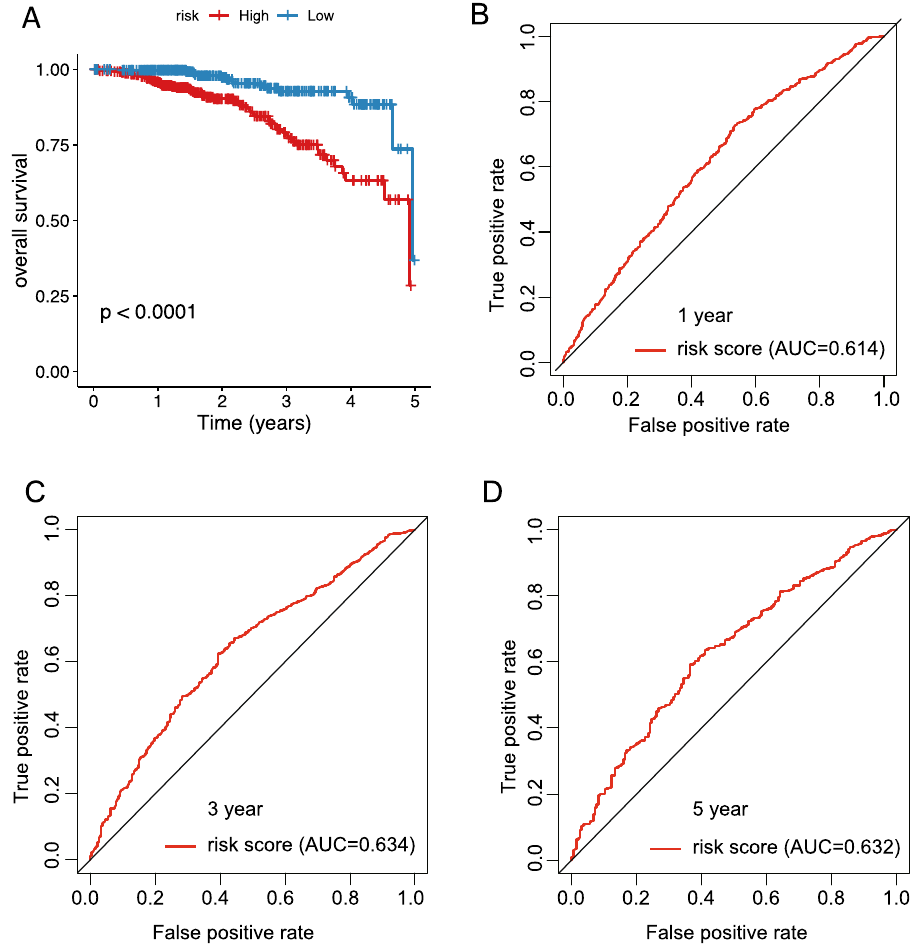
Figure 8. The accuracy of the breast cancer risk model constructed by prognostic related genes in predicting patient survival. ( A ) KM survival curves of high-risk and low-risk groups in ICGC data. ( B ) Accuracy of the time-dependent ROC assessment model in ICGC data for 1-year survival of breast cancer patients. ( C ) Accuracy of the time-dependent ROC assessment model in ICGC data for 3-year survival of breast cancer patients. ( D ) Accuracy of the time-dependent ROC assessment model in ICGC data for 5-year survival of breast cancer